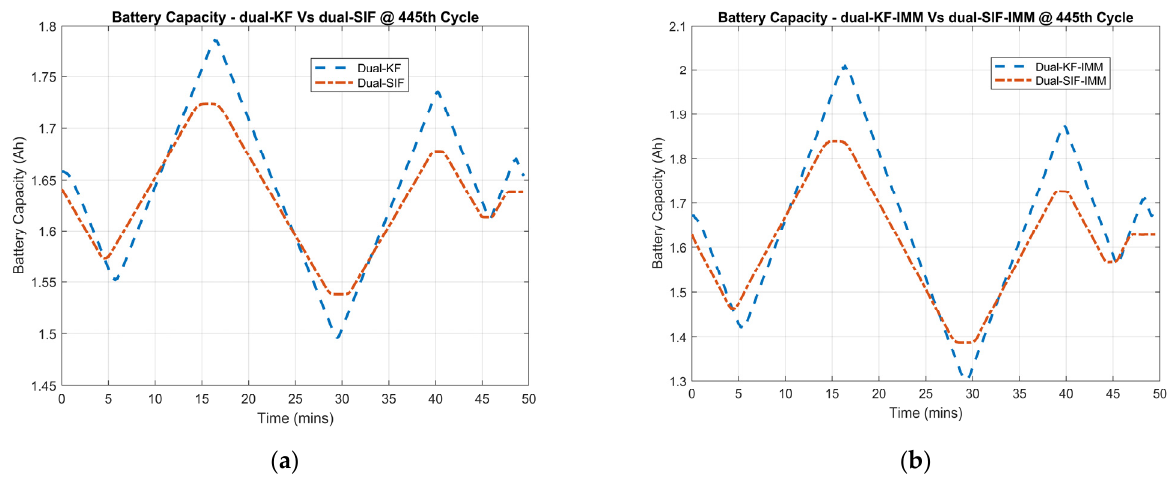
Figure 8. ( a ) Dual-KF and dual-SIF battery capacity estimates at cycle 445. ( b ) Dual-KF-IMM and dual-SIF-IMM battery capacity estimates at cycle 445.